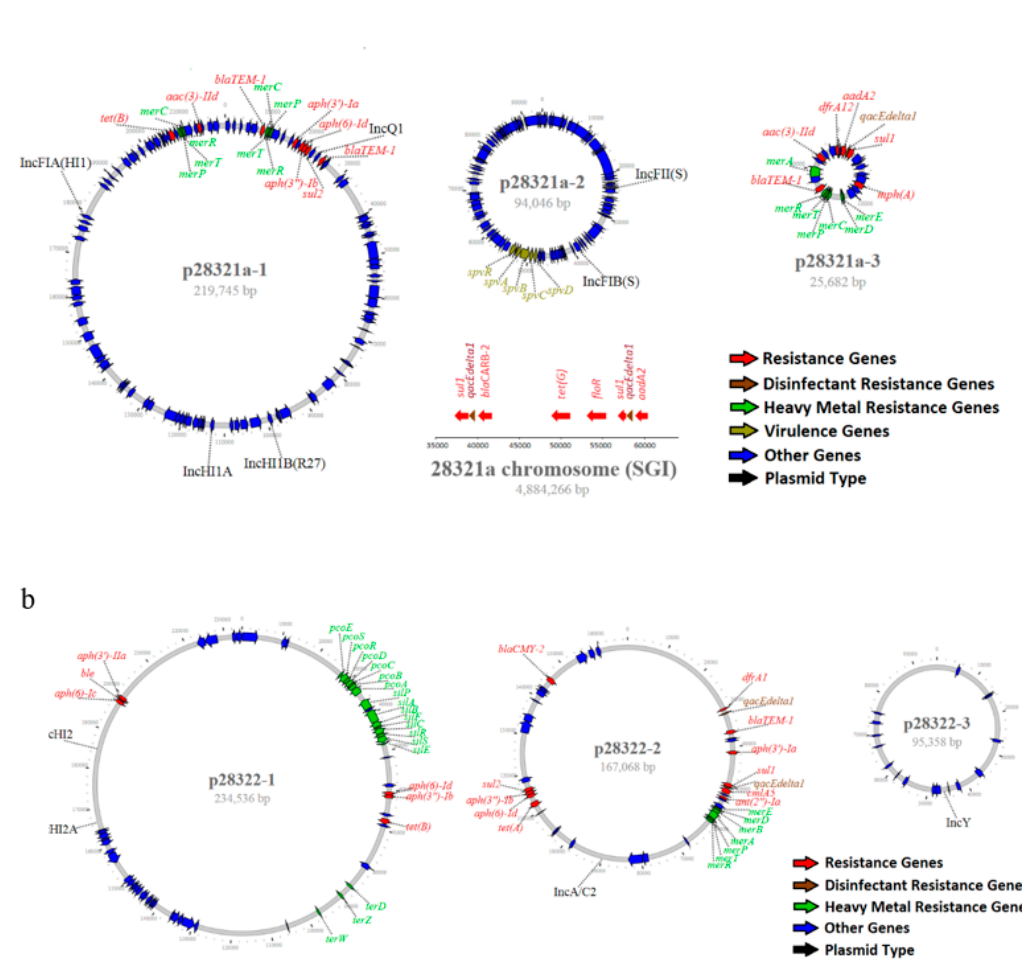
Figure 3. ( a ) Genomic structure of MDR plasmids and virulence plasmids from S. Typhimurium (O5-) (28321a) and ( b ). S . Heidelberg (28322) isolated from diseased swine. The color codes are given on the bottom right of each figure.